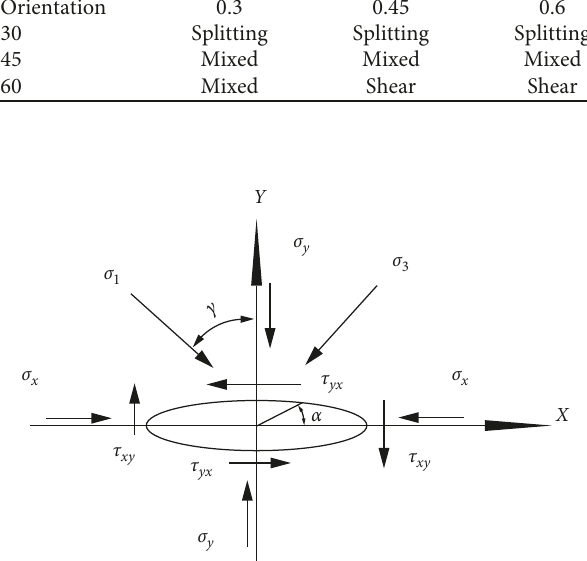
Figure 8: Stress state of the crack based on Griffith’s theory [26].